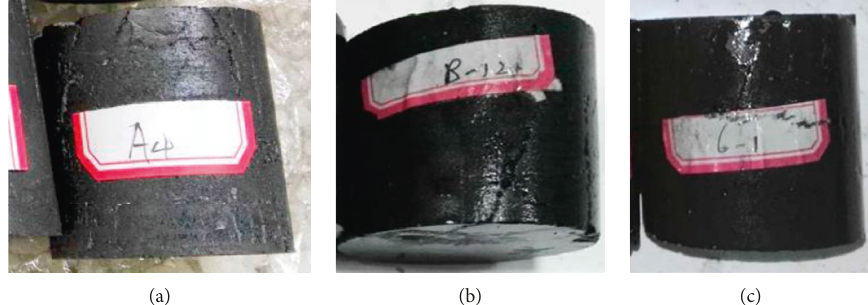
Figure 3: The photos of the collected coal masses and the prepared coal samples: (a) natural coal samples (Group A); (b) naturally saturated coal samples (Group B); (c) forcedly saturated coal samples (Group C).